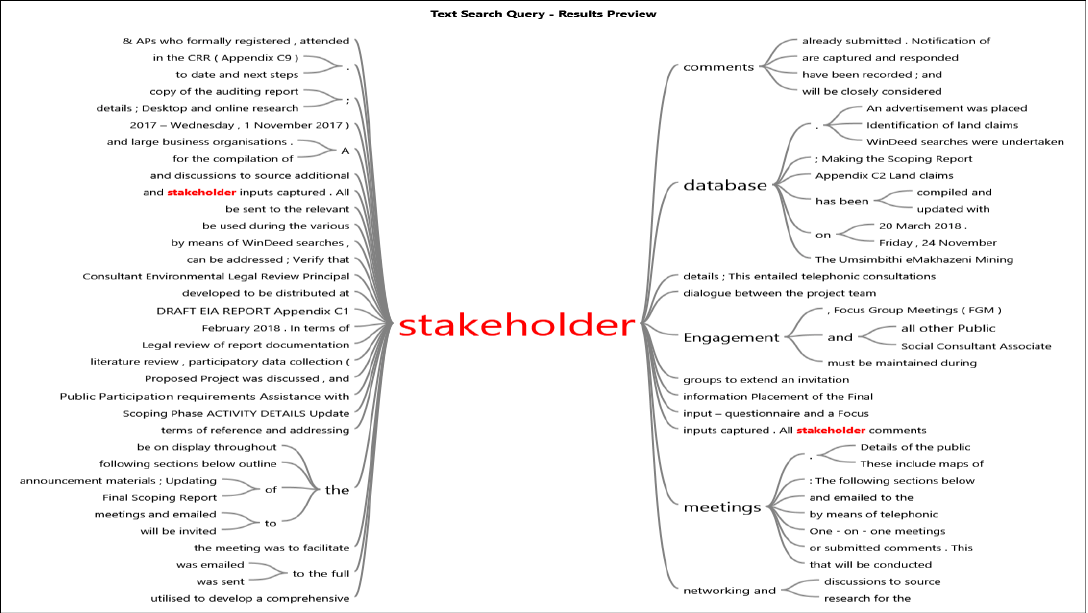
Figure A1: Word tree analysis for the EIA Report.